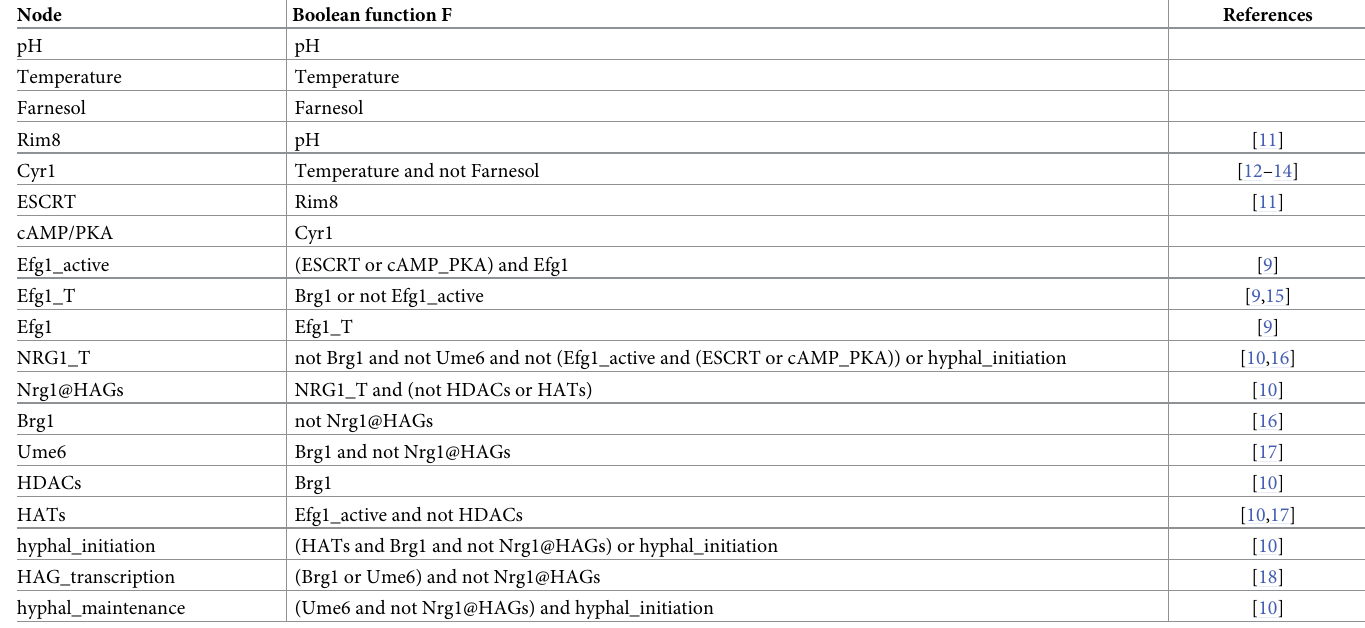
Table 1. Boolean regulatory functions of each node in the model. Each function indicates the next state of the node as a function of the current state of its regulators. For simplicity the state of each node is represented with the name of the node. The model is provided in BooleanNet (S1 File) and SBML qual (S2 File) file formats. Node Boolean function